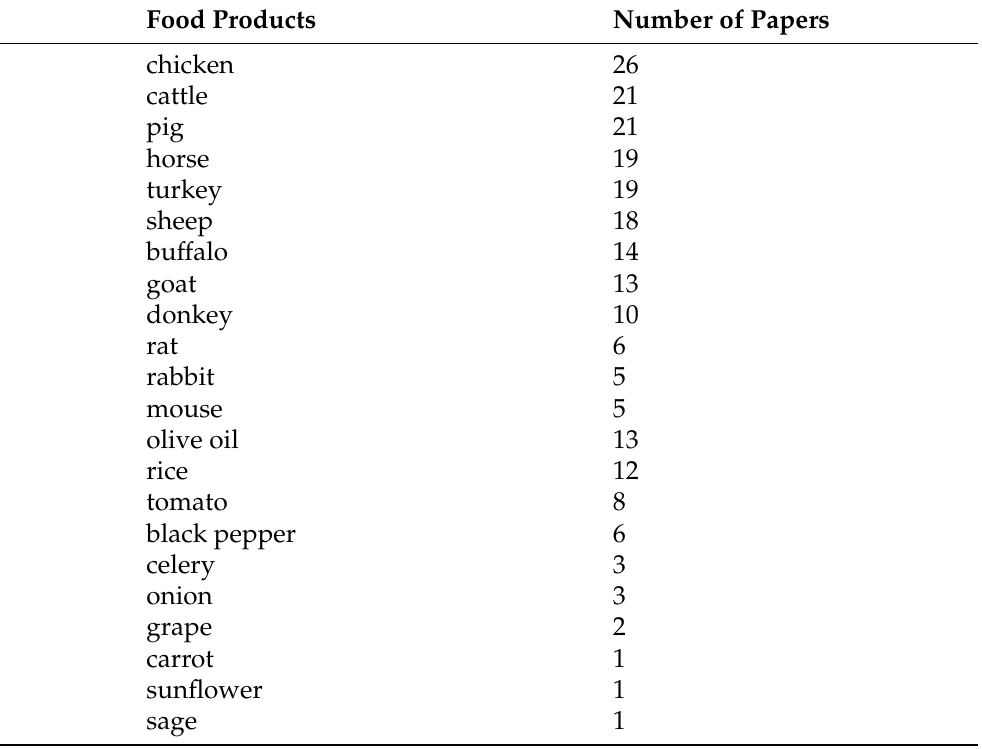
Table 3. Papers classified per food